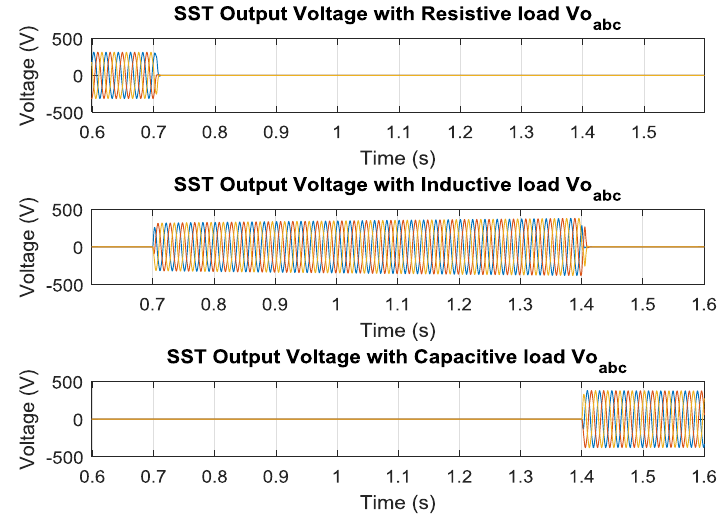
Figure 25. Filtered SST output voltage to resistive, inductive and capacitive load.